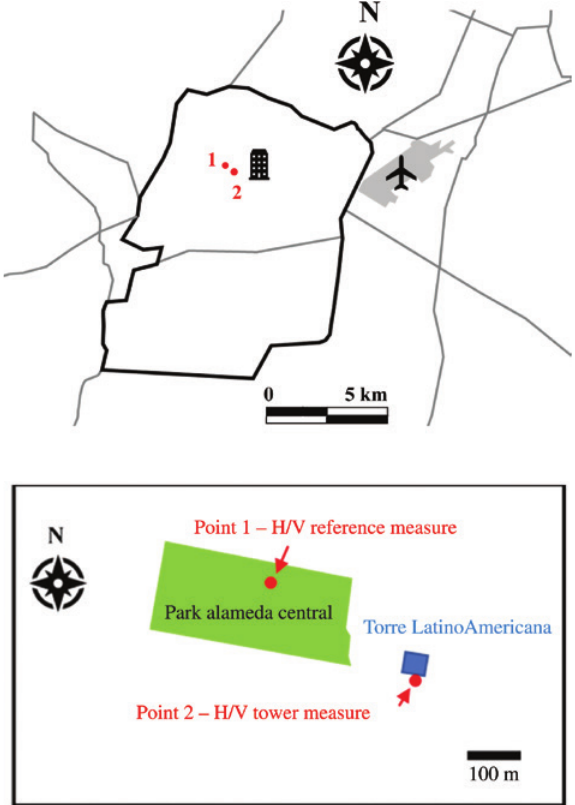
Figure 13: Schematic map of Mexico City Center and location of HVSR measures (1: reference measure; 2: tower measure), see also Table 2. Horizontal West-East distance separating 1 and 2 is 415